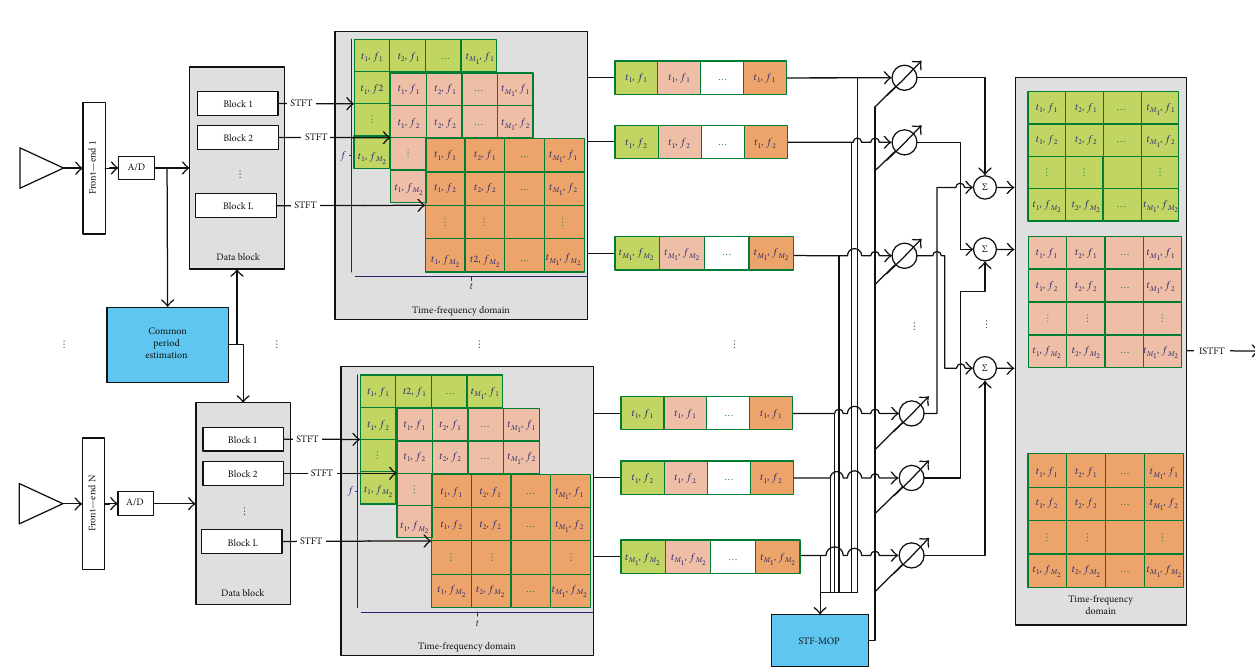
Figure 1: The frequency variation of two LFMCW interfering signals.